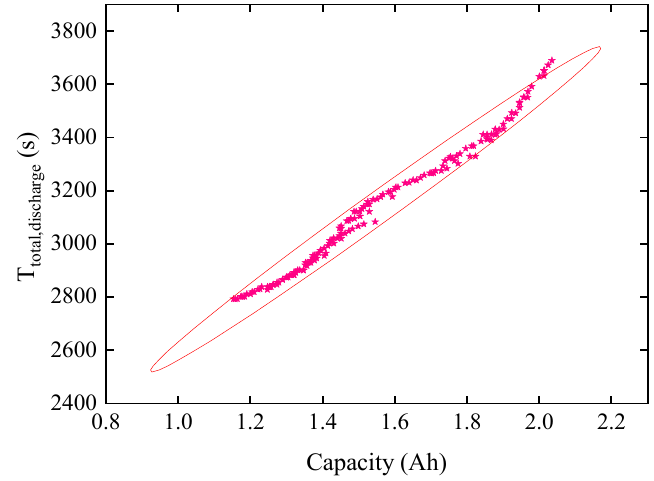
Figure 7. Scatter figure of T total,discharge .